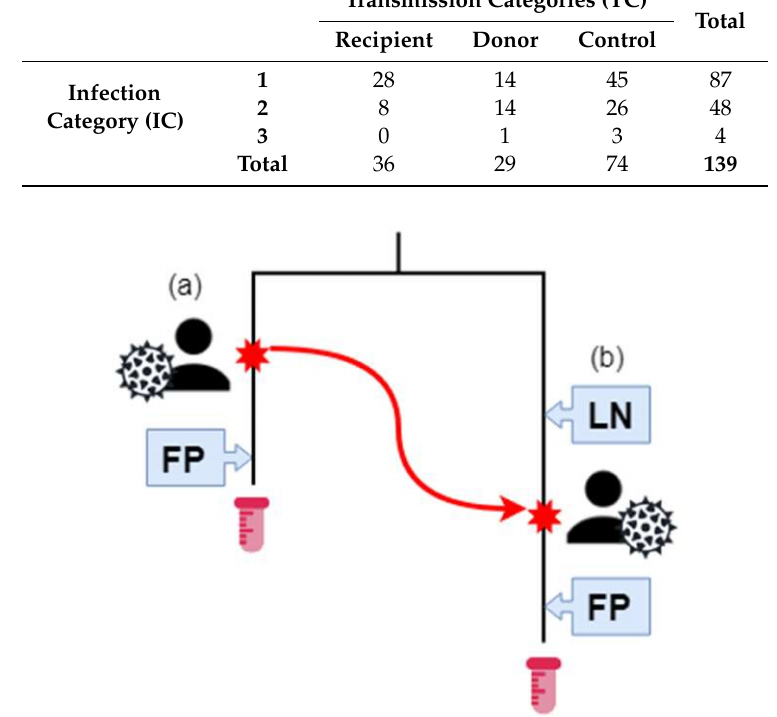
Figure 2. The Southern Alberta HIV Clinic (SAC) patient sequence and transmission data. Patient (A) has HIV, and their estimated infection date is the red star on their branch. They have a positive (First Positive—FP) HIV test result after their infection. At some time-point, represented by a red star and the red arrow, ( a ) infects ( b ). Previously, ( b ) had a negative HIV test. Afterwards, ( a ) has a positive HIV test result. The HIV sequences of samples from ( a ) and ( b ) are phylogenetically related, as represented by the tree. ( b ) is in transmission category 1 and infection category 1. ( a ) is in transmission category 2 and infection category 2. Samples for ( a ) and ( b ) were collected at the end of their respective